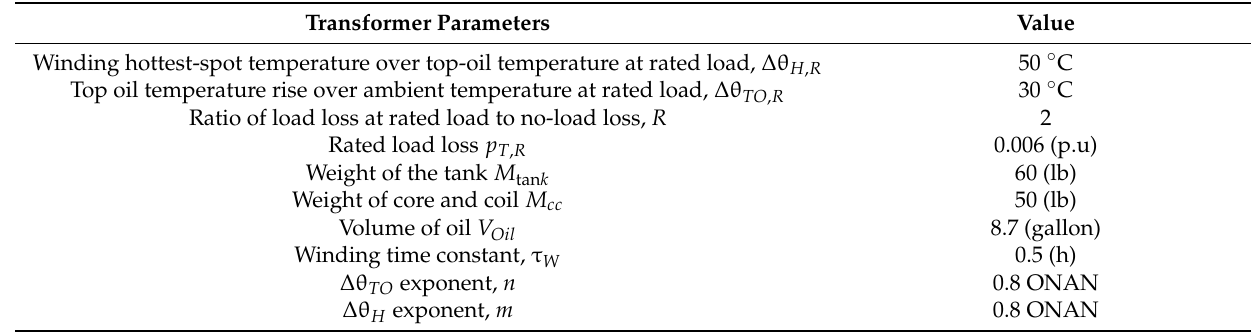
Table A1. Transformer thermal and aging parameters used in the model.